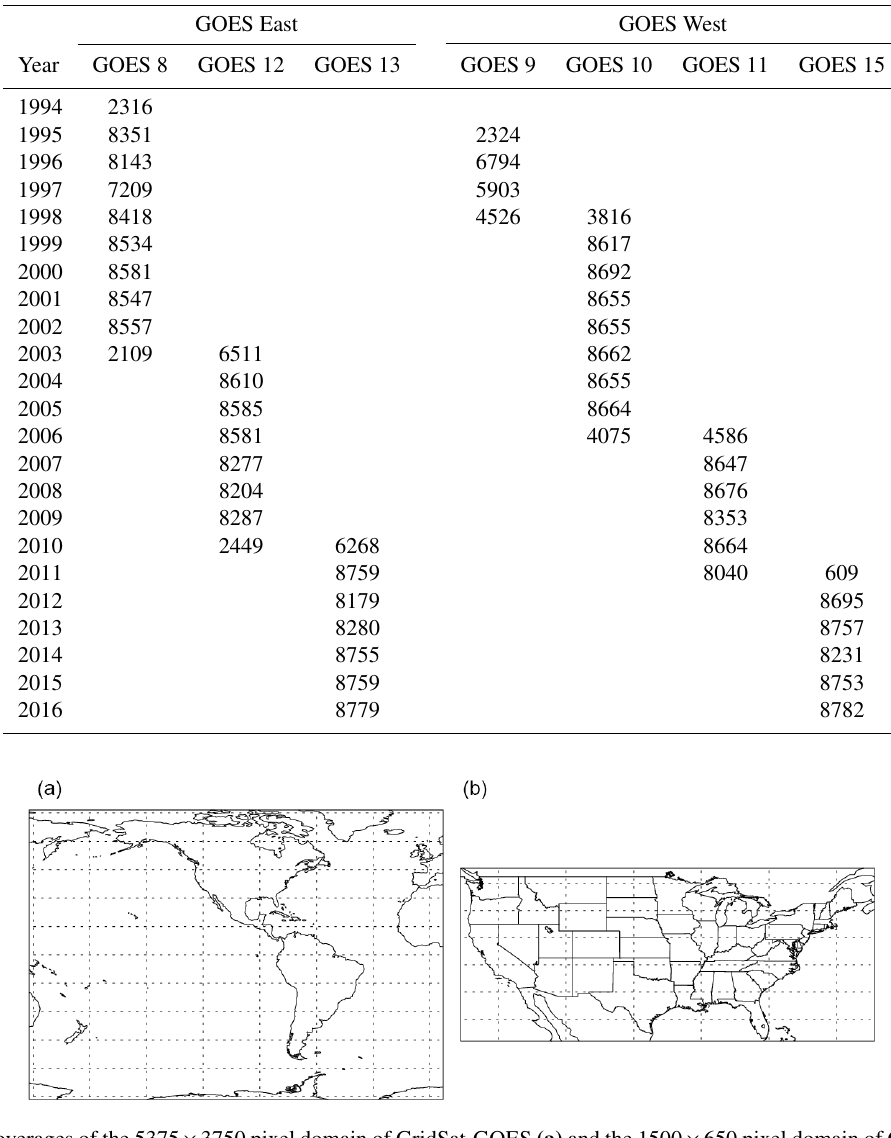
Table 4. Number of files per satellite per year for GridSat-GOES.